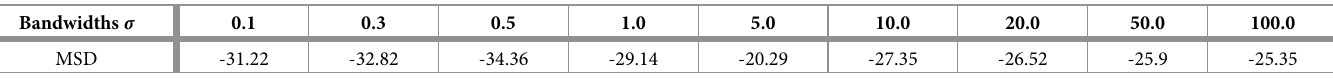
Table 1. MSDs with different kernel bandwidths σ